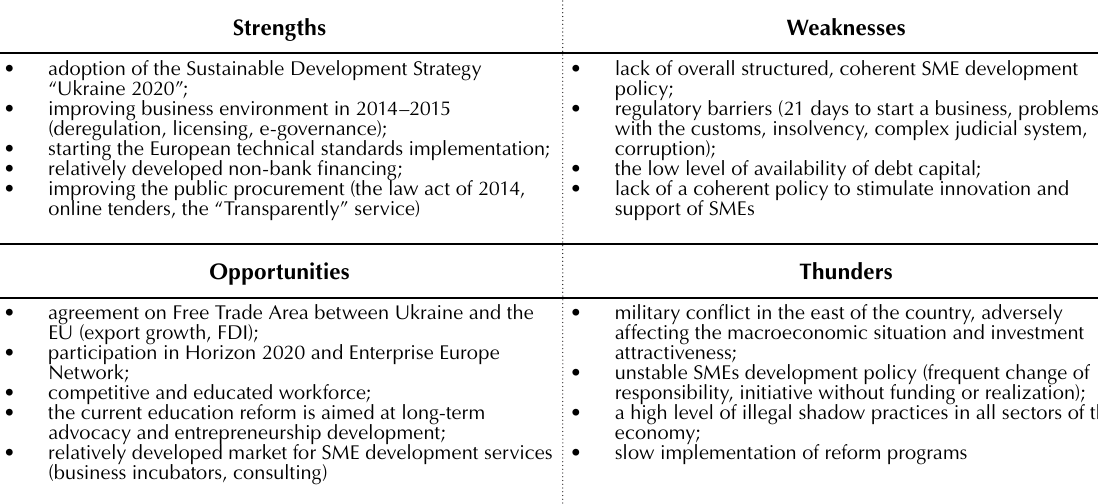
Table 2. SWOT-analysis of SME Development Policy Implementation in Ukraine, 2016